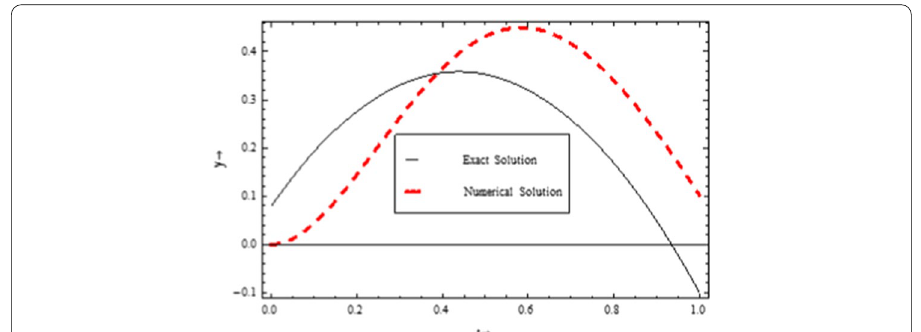
Fig. 1 The exact and the approximate values of Eq. (15) for m = 2 in Example 1